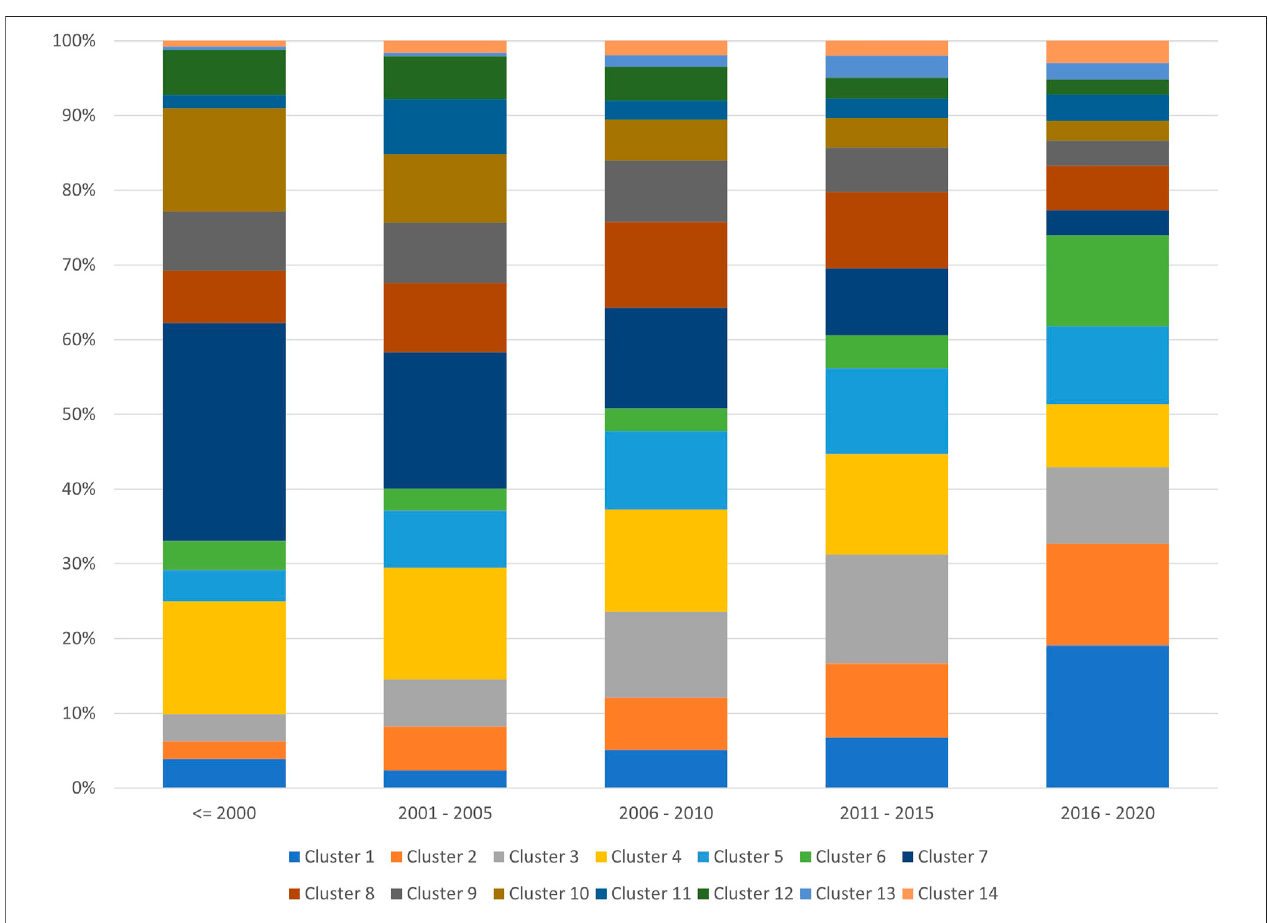
FIGURE 6 | Topical cluster proportion for different windows of time until